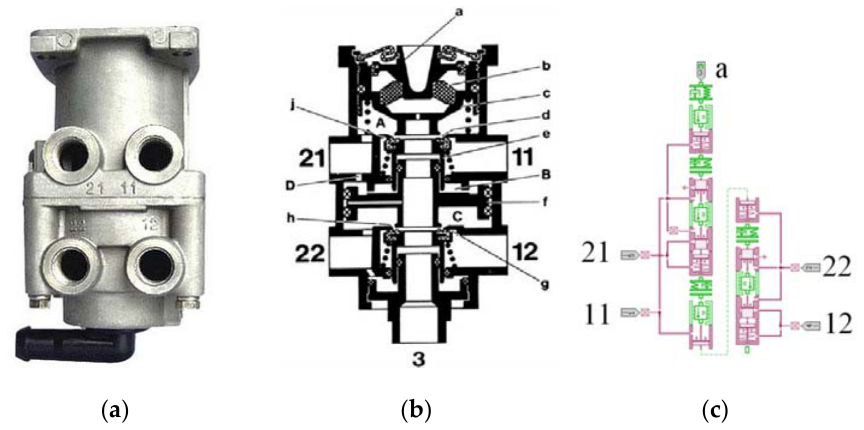
Figure 2. Series dual ‐ chamber air brake valve. ( a ) Appearance. ( b ) Schematic diagram. ( c ) Submodel